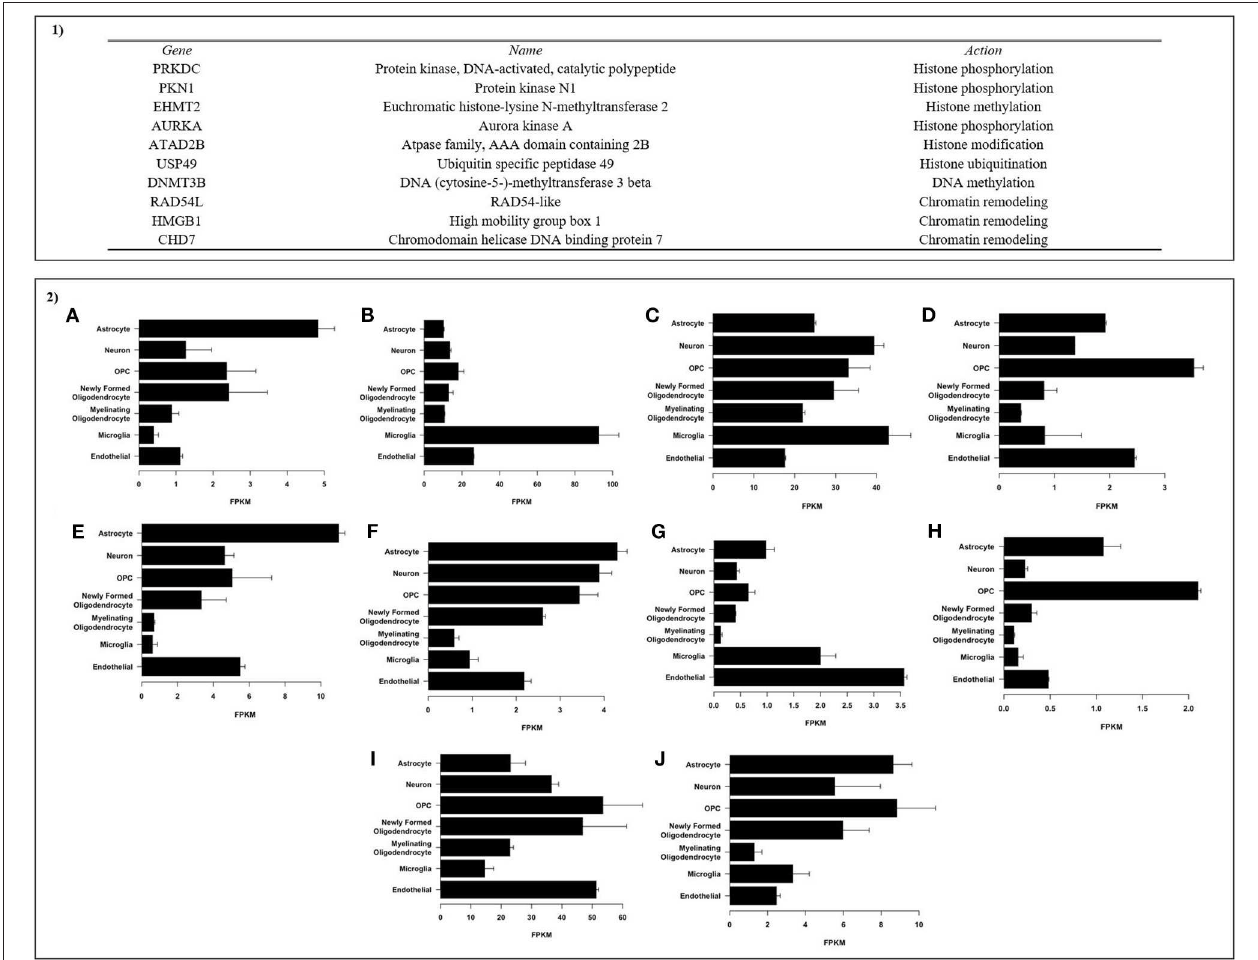
FIGURE 7 | Epifactors included in the expression-based polygenic risk score of the 5-HTT in the amygdala: (1) Genes classified as epifactors, involved in histone phosphorylation and methylation, chromatin remodeling, and DNA methylation; (2) Cell classes in the brain where these epifactors are expressed. Each graphic represents a gene: (A) PRKDC, (B) PKN1, (C) EHMT2, (D) AURKA, (E) ATAD2B, (F) USP49, (G) DNMT3B, (H) RAD54L, (I) HMGB1, and (J)